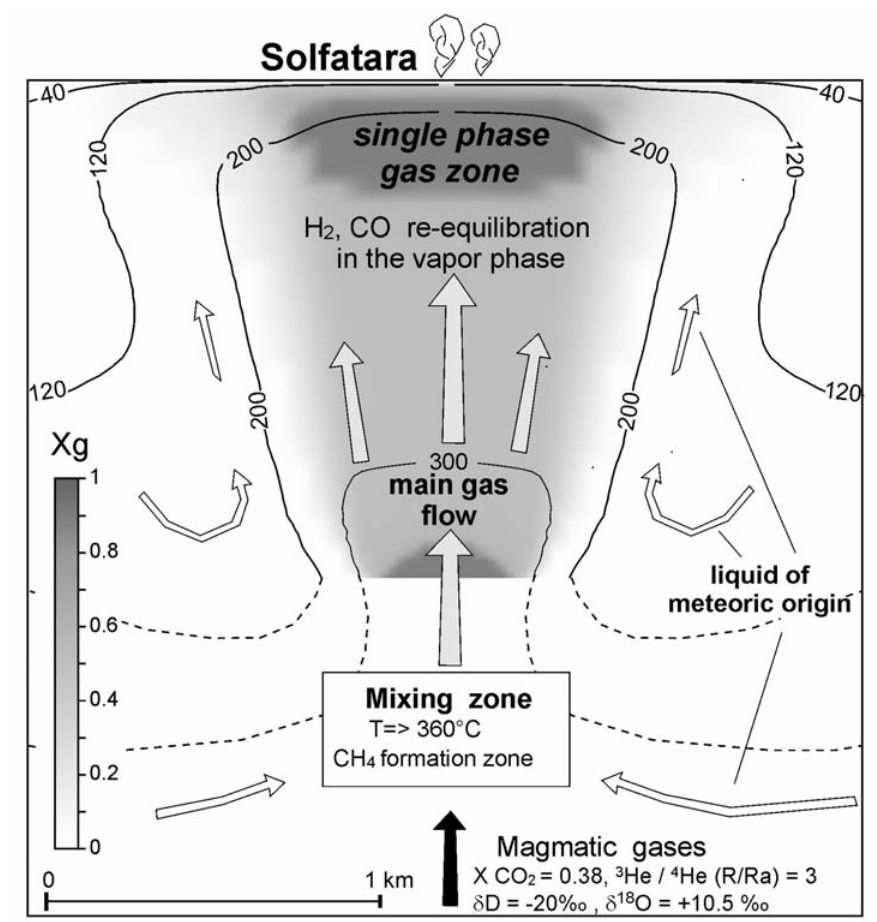
Figure 2. Revisited geochemical conceptual model of Solfatara, showing the zones of deep mixing, and H (after Caliro et al. 2007). The gas/liquid mass fractions (Xg), and low-temperature isotherms are shown, as arising from the physical–numerical simulations described in detail by Chiodini et al. [2003] and Todesco et al. [2003]. The gas fractions are indicated by the gray shading